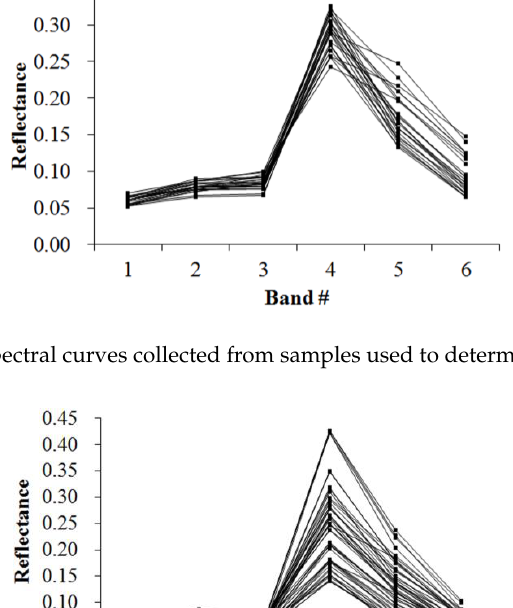
ISPRS Int. J. Geo-Inf. 2016 , 5 , 154